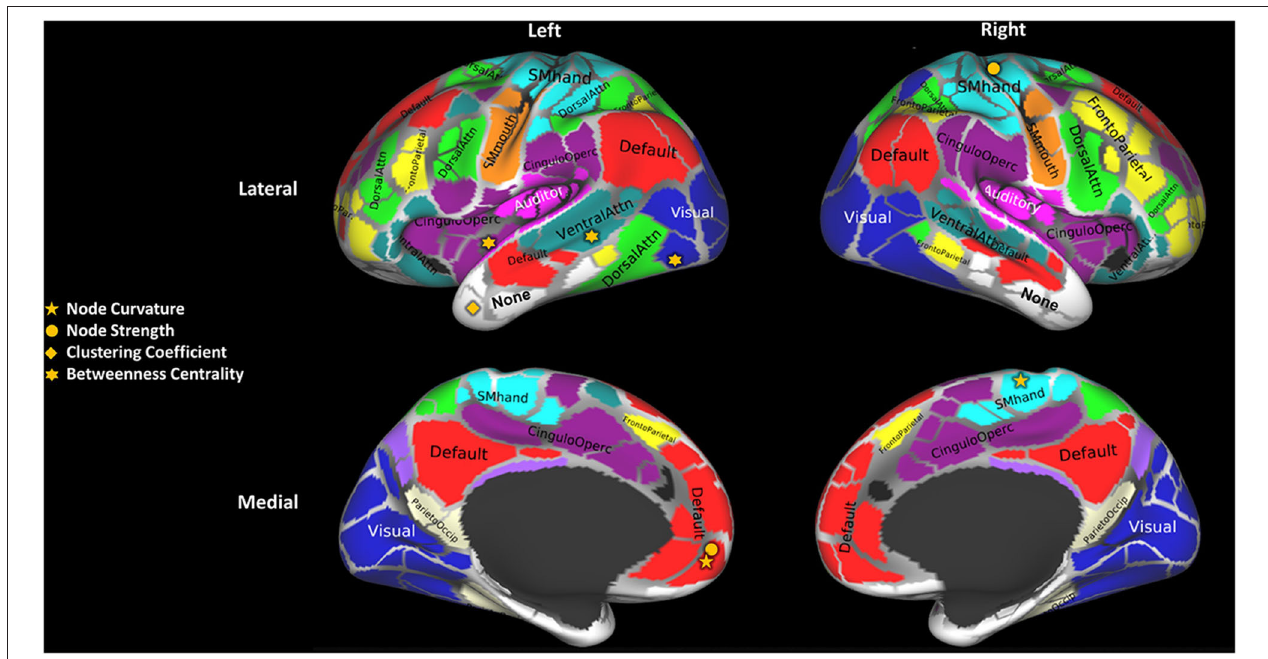
FIGURE 1 | Cortical areas (network nodes) with statistically significant differences (corrected for multiple comparisons using the Holm–Sidak method) between MS cognitively impaired (MSCI) and non-impaired (MSNI) patients. Brain parcellation with 333 cortical areas was obtained using the Gordon atlas (19) and labeled with the